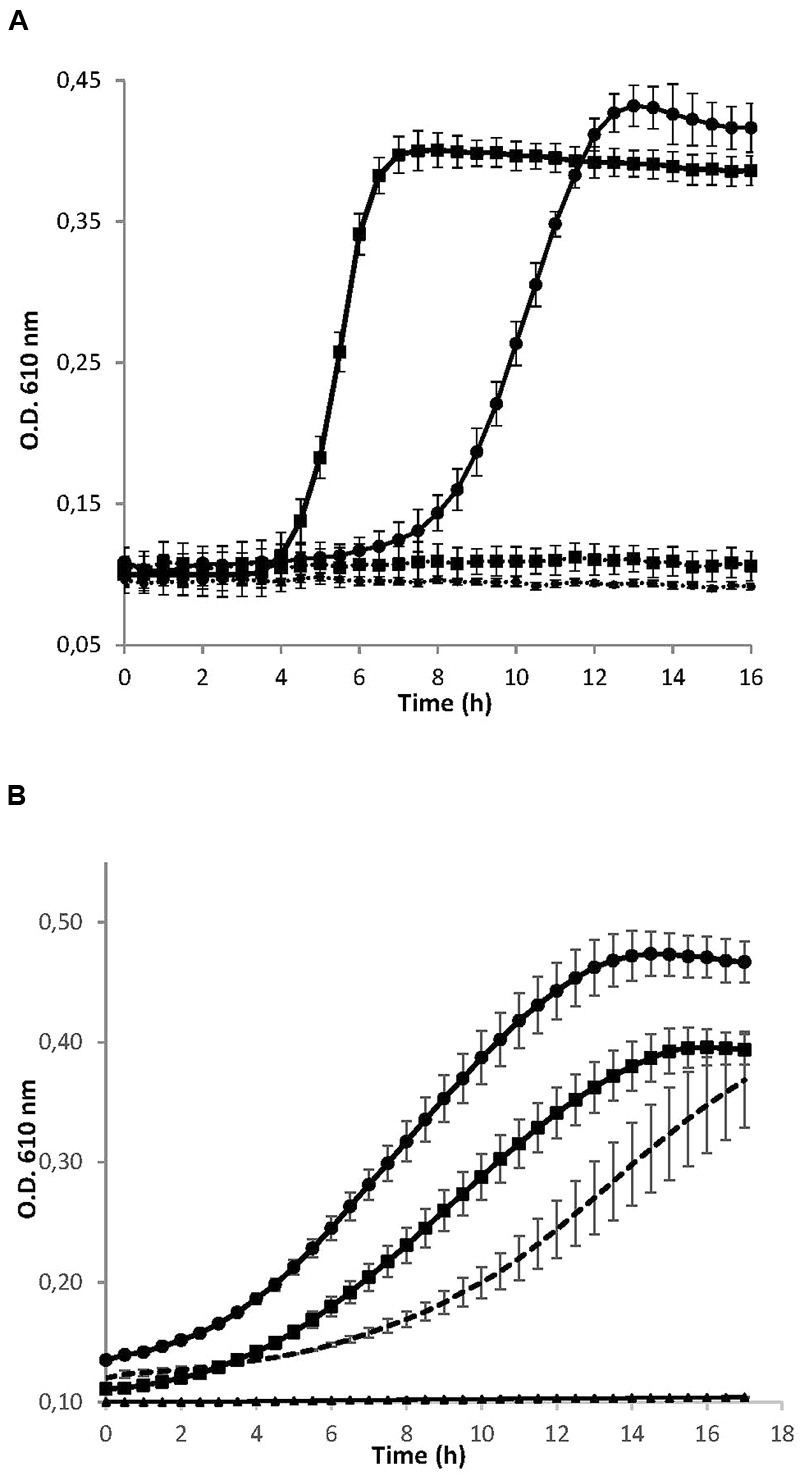
(A) Growth curves of the cariogenic bacteria Streptococcus mutans ATCC 25175 (squares) and S. sobrinus CECT 4034 (circles) in the presence (dotted lines) and absence (solid lines) of concentrated supernatant of S. dentisani strain 7746. (B) Growth curves of S. mutans ATCC 25175 in the presence of different size fractions of the 10× concentrated supernatant of S. dentisani 7746. Circles correspond to the fraction >10 KDa, squares to the 3–10 KDa fraction, and triangles to the fraction <3 KDa. For comparisons, S. mutans was grown in the presence of 10x concentrated BHI medium (dotted line). Means ± SD from three independent replicates are plotted.